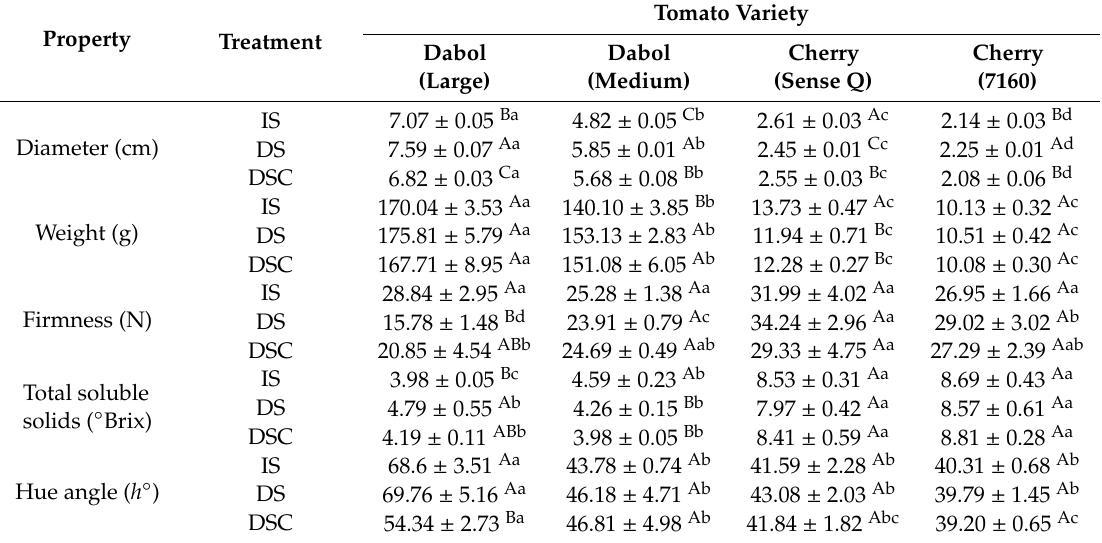
Table 2. Properties of the tomato cultivars at